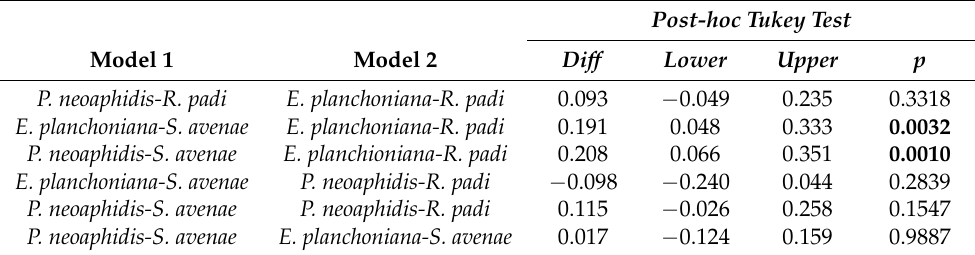
Table 6. Results of post-hoc Tukey test for multiple comparisons of means with 95% family-wise confidence level. Abbreviations: diff = difference between group means, lower = lower end point of the interval, upper = upper end point of the interval, p = significance level. Values in bold indicate significant differences ( p ≤ 0.05) between the different non-linear regression models.